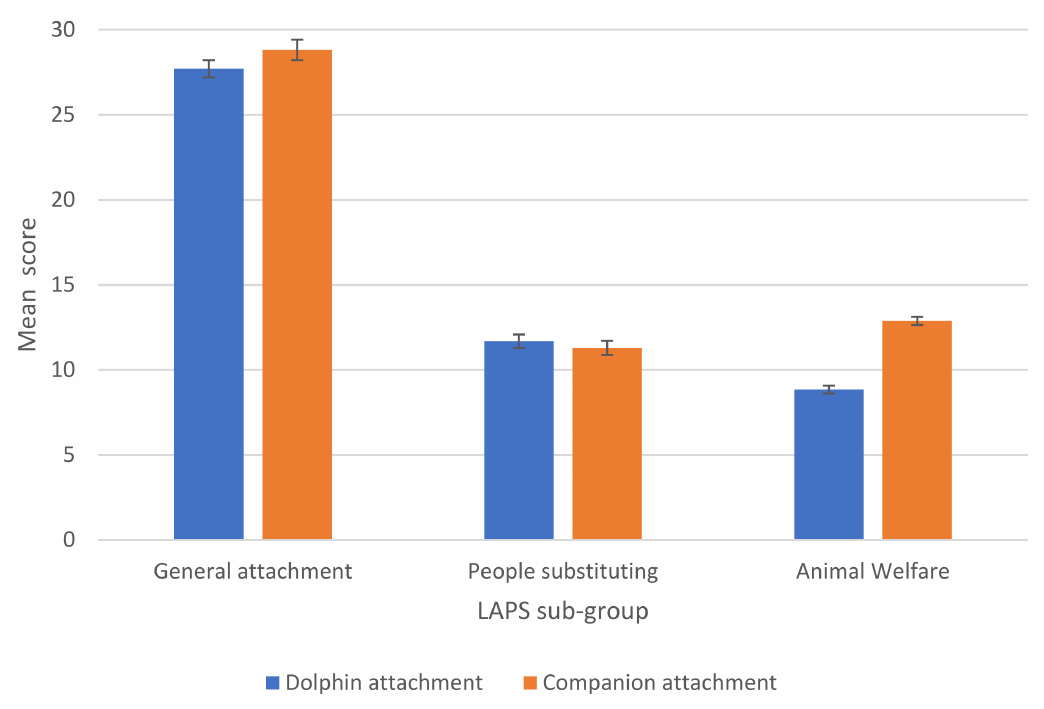
Figure 2. Mean dolphin and companion attachment scores separated by sub-group.